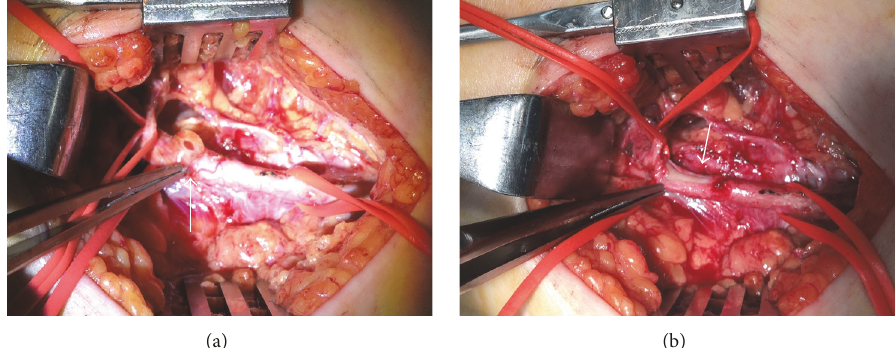
Figure 5: Clear viscous liquid flowed out after cutting the adventitial layer (arrow). (b) After resection of cystic adventitial lesion (arrow).